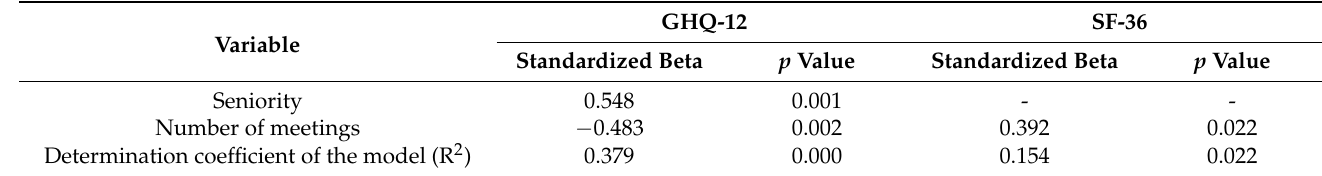
Table 2. Stepwise linear regression analysis. Relationship between demographic and intervention-related variables and